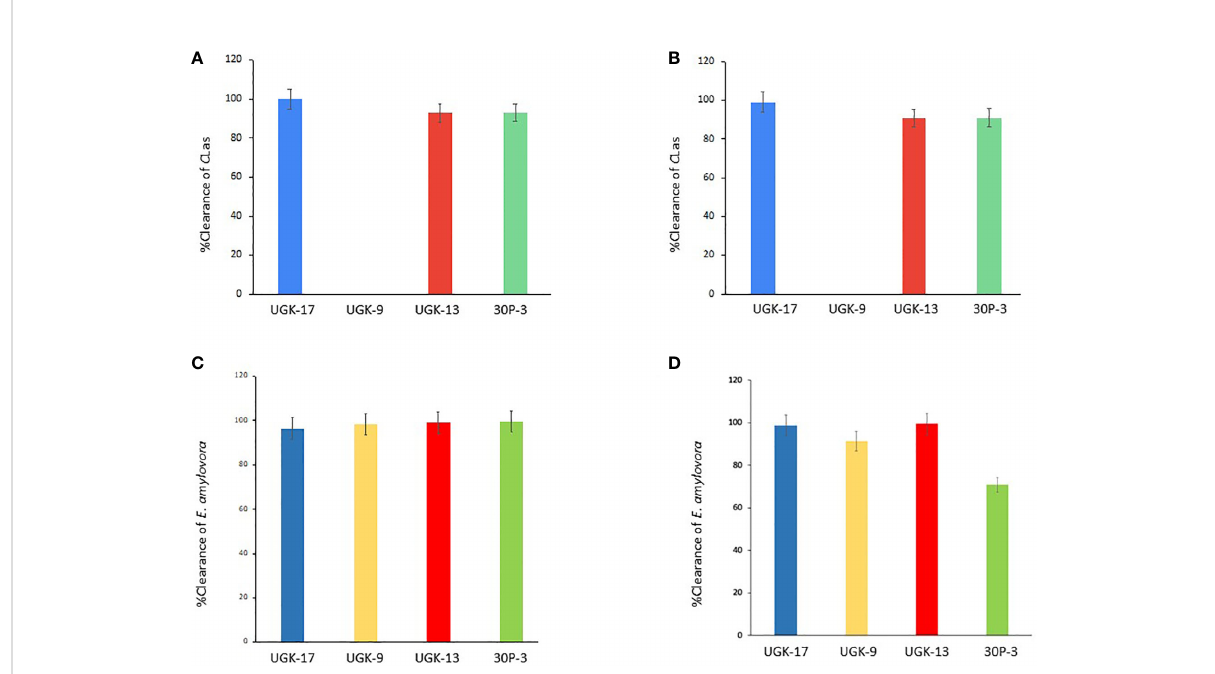
FIGURE 6 Bacterial clearance of Candidatus Liberibacter asiaticus ( C Las) (A, B) and Erwinia amylovora (C, D) by DNA and RNA quantitative PCR